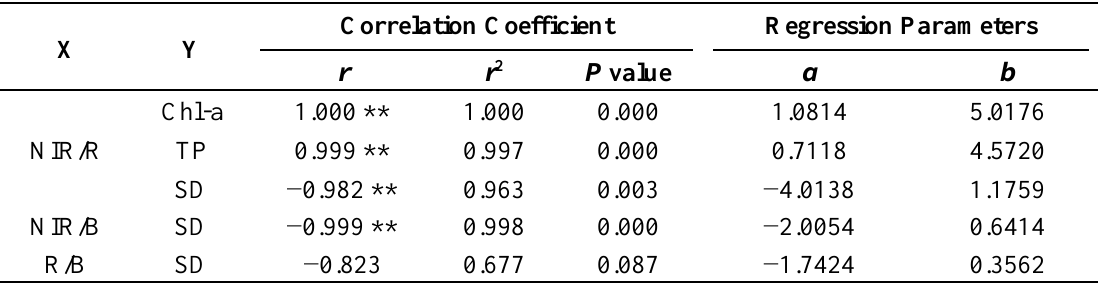
Table 6. Optimal correlation and regression coefficients obtained by the MPP method, coupled with a 5 × 5 pixel